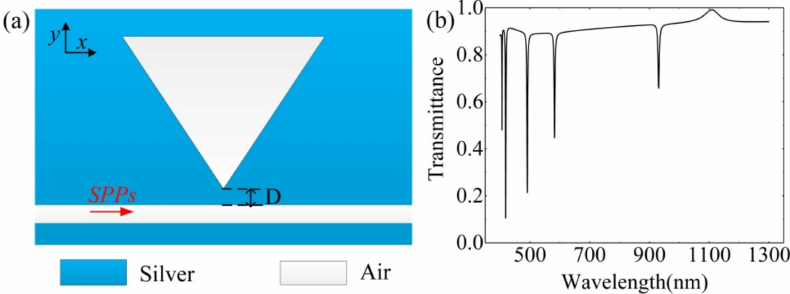
Figure 3. ( a ) The schematic of the inverted ETSC; ( b ) the transmittance spectrum of the inverted